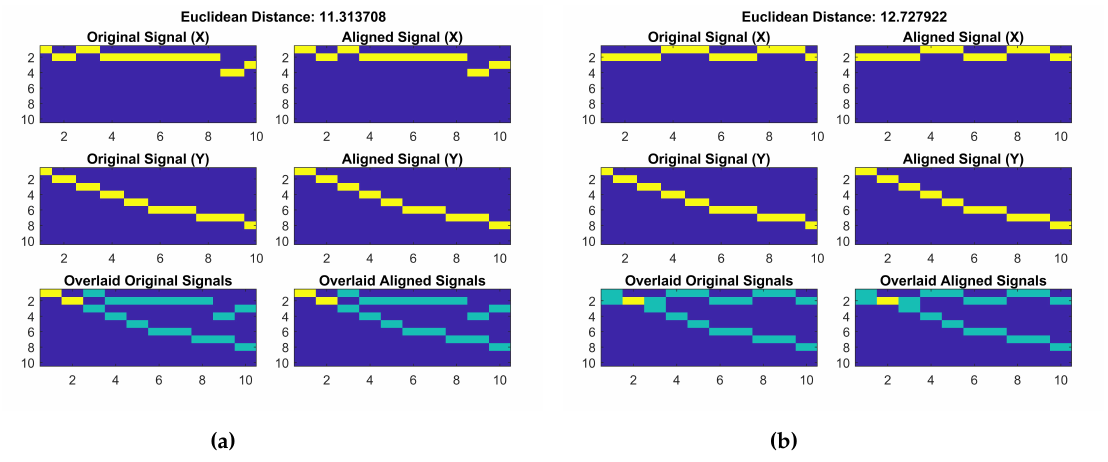
Figure 6. The distance between the magnetic patterns over different time. ( a ) Euclidean distance for pattern 1; ( b ) Euclidean distance for pattern